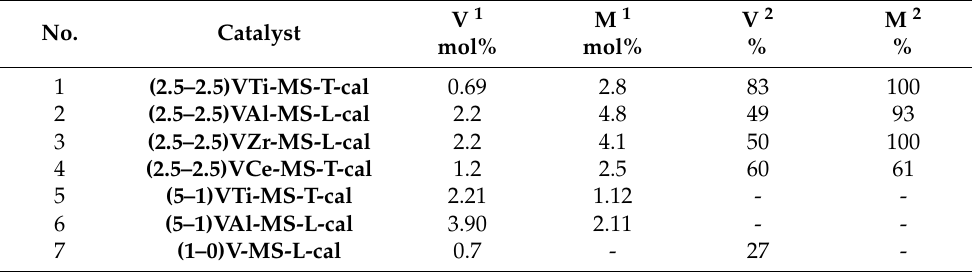
Table 1. Metal loading and residual percentage after leaching test in